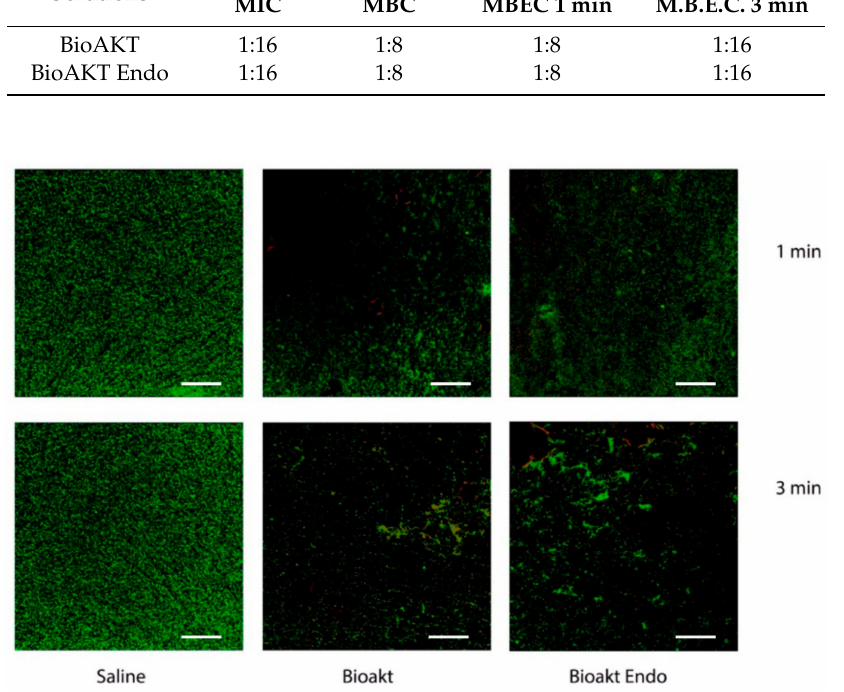
Figure 1. C.L.S.M. 3D images of E. faecalis biofilms treated with the tested solutions and control (saline solution). Live cells are seen in green, whereas dead cells are seen in red. Scale bar: 100 µ m.